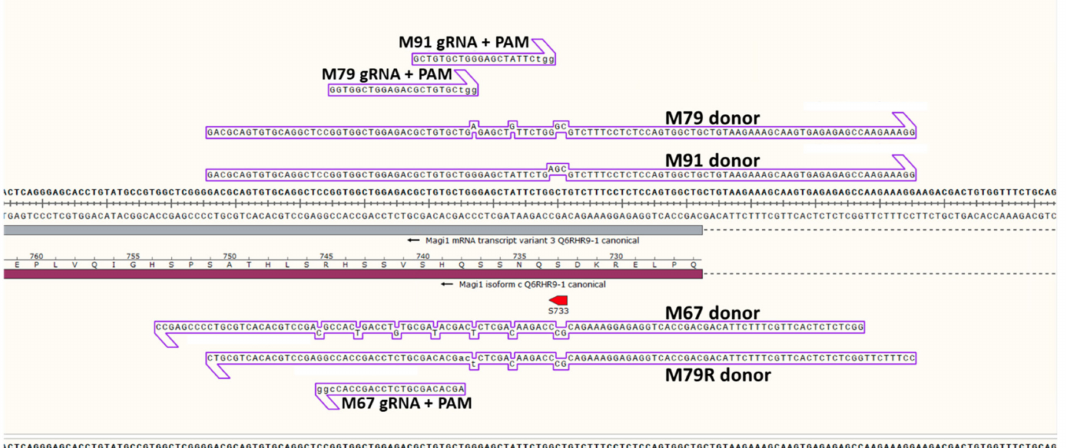
Figure 1. Magi1 guide and donor pair sequences. Four guide / donor pairs were used to alter serine 733 in the mouse Magi1 gene to alanine. The M67, M79 and M91 guides had donors containing the variable region of the guide sequence (except guides had U in place of T) and these guide RNA regions are shown with the adjacent PAM in lower case. We also used the M79 guide with another donor, M79R donor, containing sequence complementary to the variable region of the M79 guide. Donor point mutations are shown out of line with the main donor